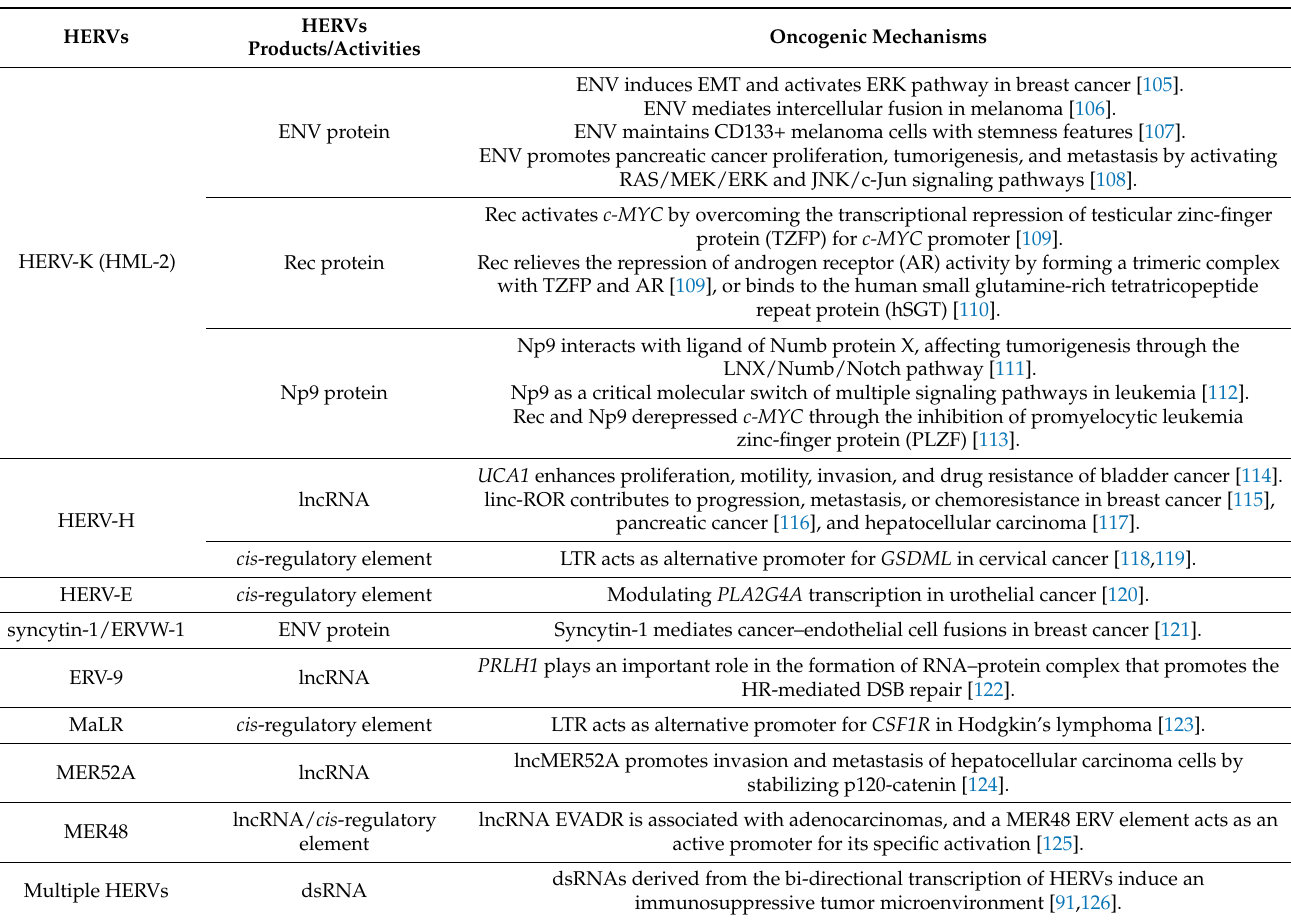
Table 2. HERVs and oncogenic mechanisms in human